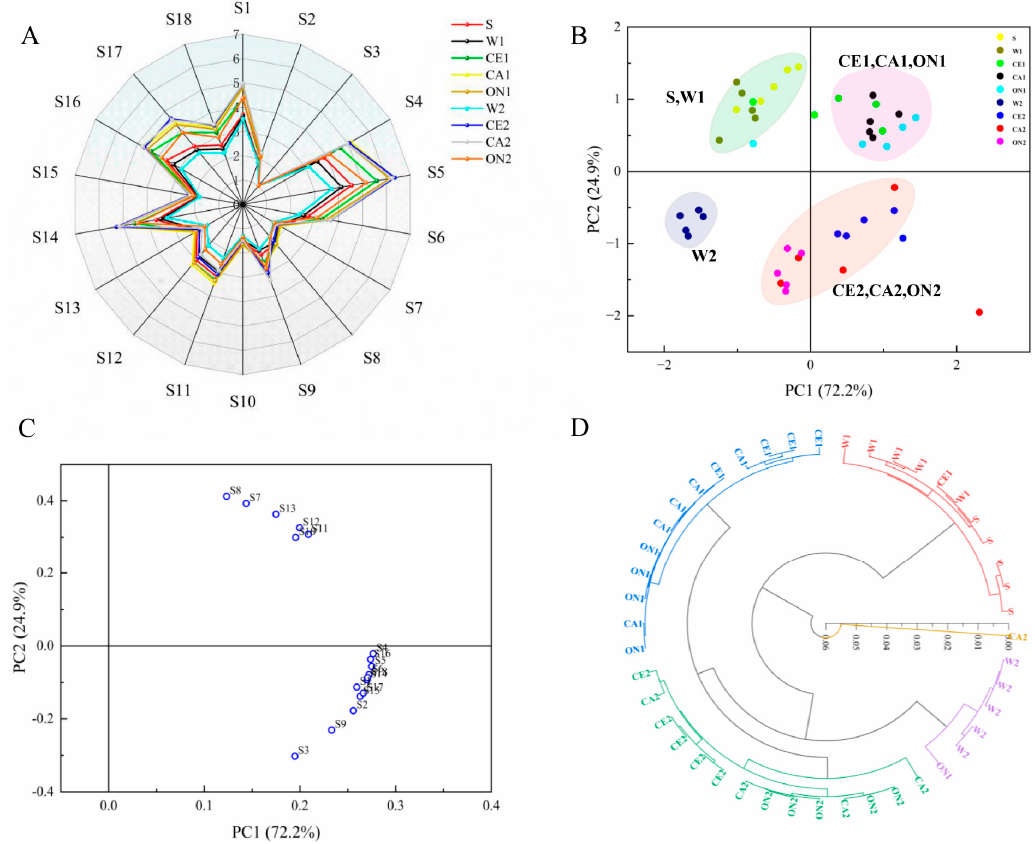
Figure 2. Radar plot ( A ), PCA score plot ( B ), loading plot ( C ), and HCA analysis plot ( D ) of soy sauce based on e-nose response data.